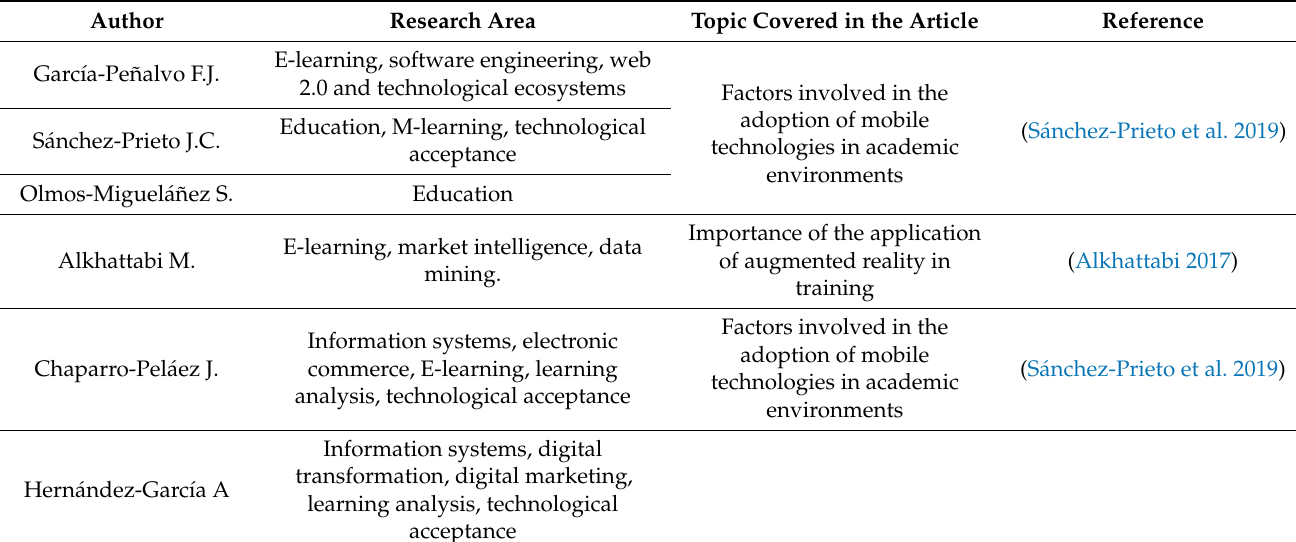
Table 1. Main topics and areas of study of the most cited authors of publications on virtual tools in teaching-learning